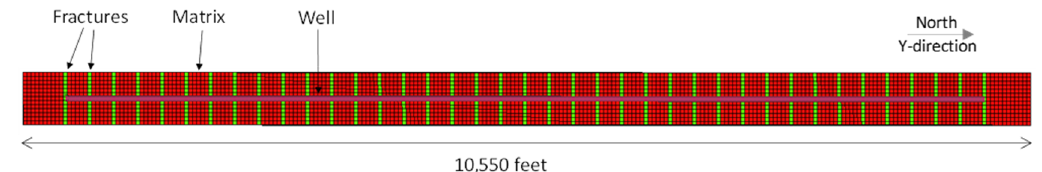
Figure 4. The horizontally gridded reservoir model represents a single well in an unconventional reservoir. A dual co-located grid system is used where the hydraulic fractures are in one grid and the matrix properties are in the other grid and a transfer function allows interaction between the two grids. The fractures are 250 feet apart from each other.